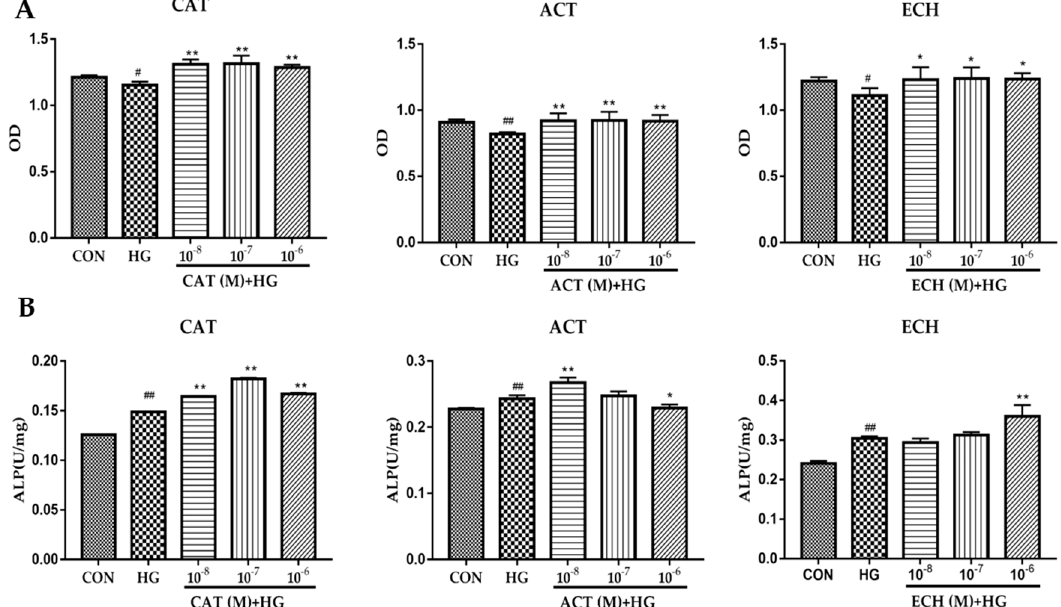
Figure 4. E ff ects of catalpol (CAT), acteoside (ACT), and echinacoside (ECH) against high-glucose induced injury to osteoblastic MC3T3-E1 cells. The osteoblastic MC3T3-E1 cells were treated with CAT, ACT, and ECH for 48 h, and then injured with 200 mM glucose for 48 h. ( A ) Cell viability was assayed with a CCK-8 kit ( n = 5); ( B ) ALP activity was determined by using an ALP activity assay kit ( n = 3). All data are expressed as the mean ± SD. # p < 0.05 and ## p < 0.01 as compared with the normal control group, and * p < 0.05 and ** p < 0.01 as compared with the high-glucose treatment group.